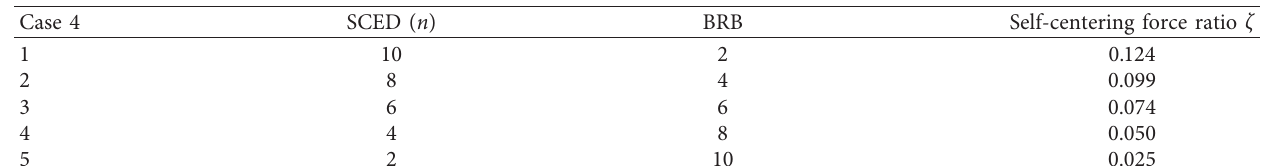
Figure 14: The lateral displacement of the girder and arch rib of a continuous beam-arch bridge: (a) girder; (b) arch rib. Table 8: Combined design scheme of SCED and BRB.